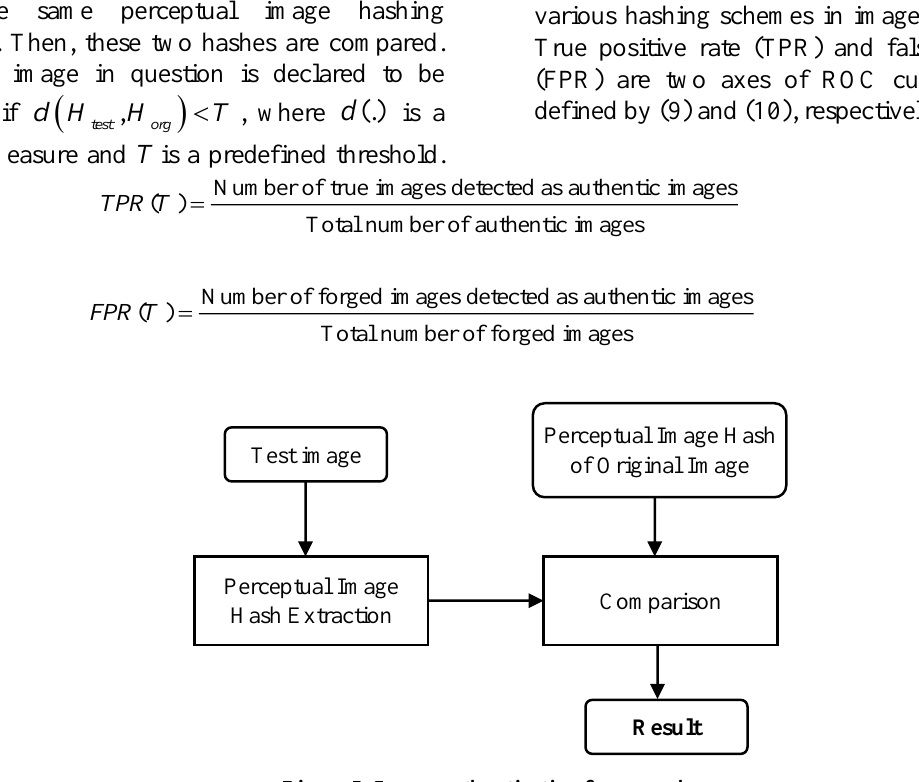
Figure 5. Image authentication